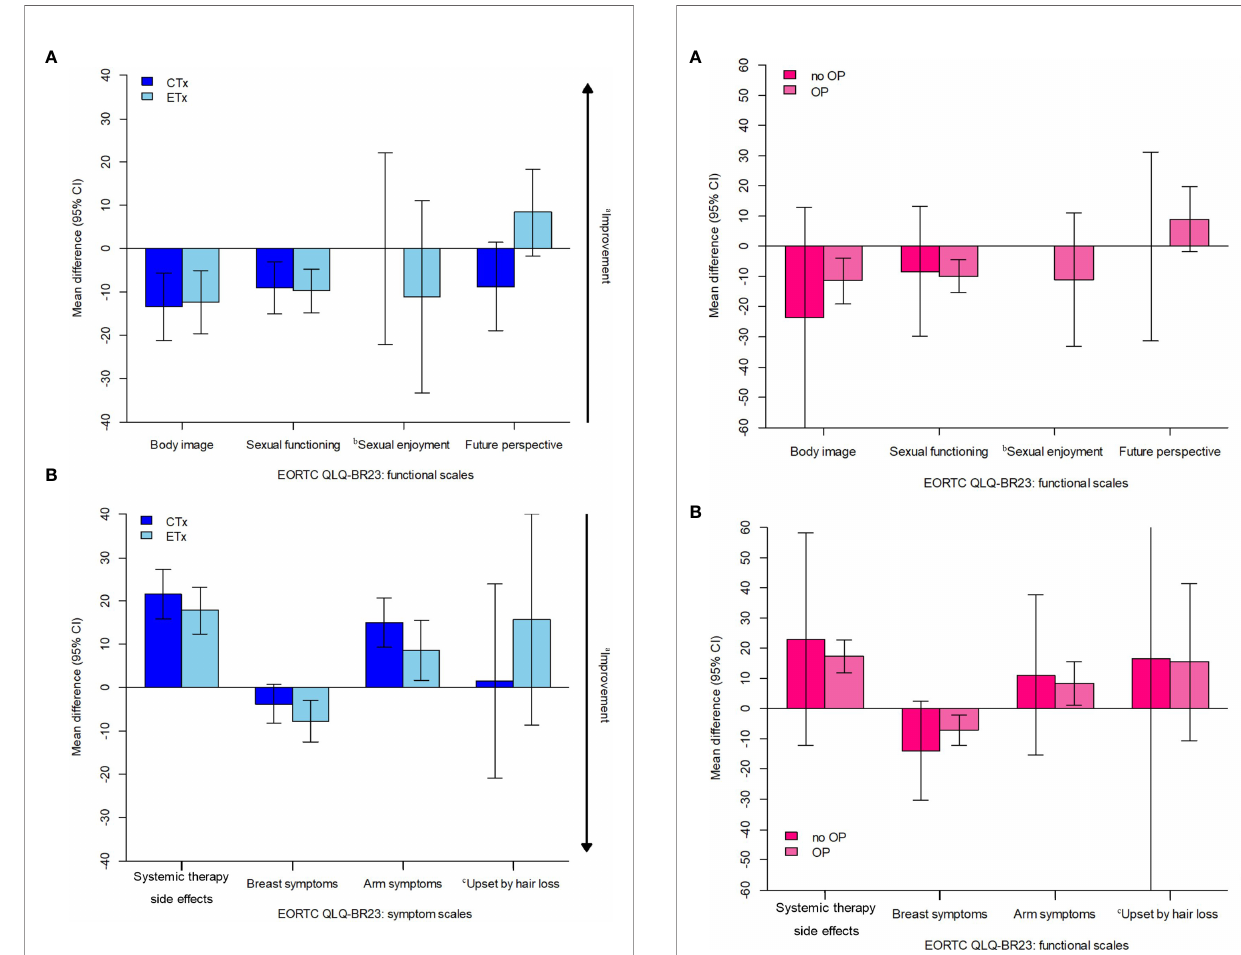
FIGURE 3 | Estimated overall change from baseline in PRO-evaluable population. CI, con fi dence interval; CTx, chemotherapy; EORTC, European Organisation for Research and Treatment of Cancer, ETx, endocrine therapy; NCT, neoadjuvant chemotherapy; NET, neoadjuvant endocrine therapy; PRO, patient-reported outcome; QLQ-BR23, Quality of Life Questionnaire breast cancer module; QoL, quality of life. (A) EORTC QLQ-BR23: functional scales, (B) EORTC QLQ-BR23: symptom scales. a Arrow denotes direction of improved outcome. b The sample sizes for the "sexual enjoyment" functional scale was smaller than other functional scales because patients were asked to respond to this question only if they responded in a previous question that they were sexually active. c The sample sizes for the ‘ upset by hair loss ’ symptom scale was smaller than other symptom scales because patients were asked to respond to this question only if they responded in a previous question that they were experiencing hair loss.